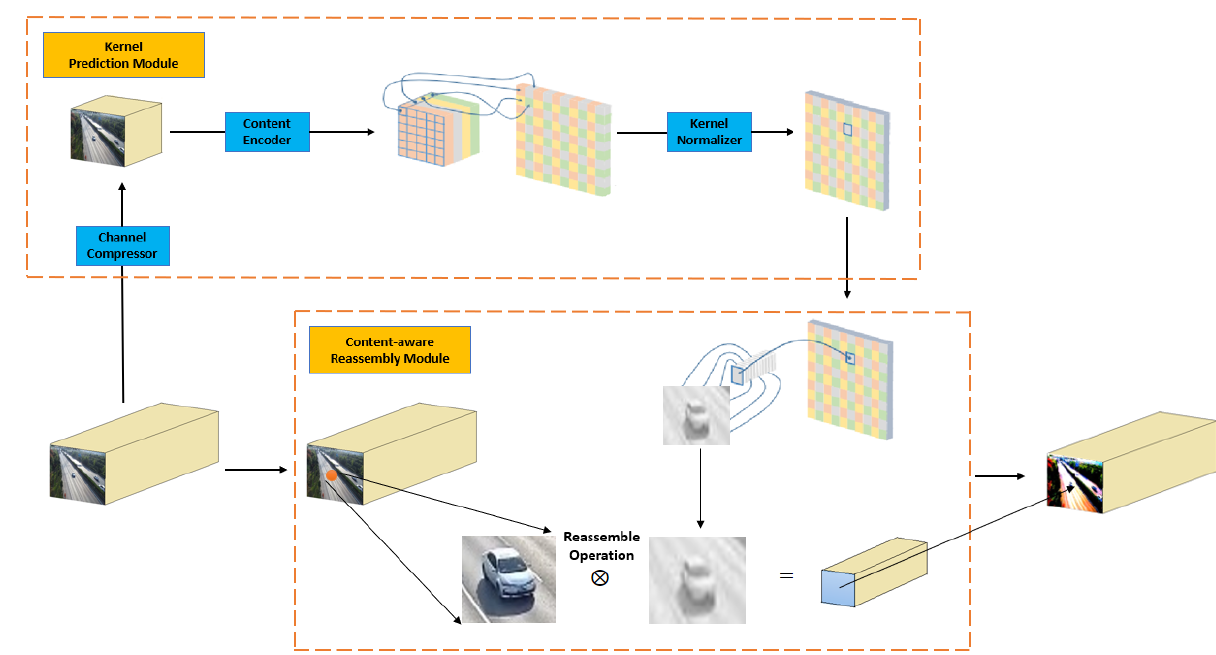
Figure 4. The overall framework of